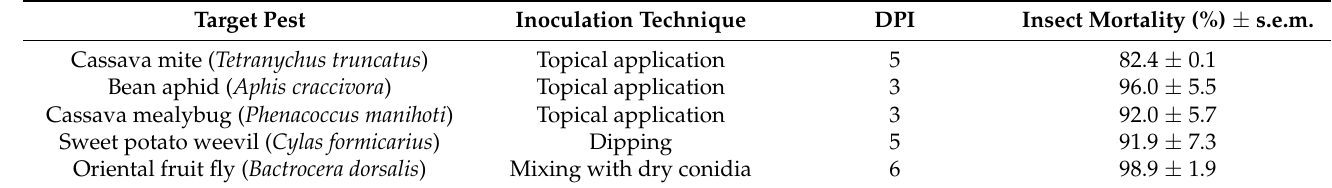
Table 2. Virulence of Metarhizium sp. BCC 4849 against various insect pests, inoculation techniques, and effects on insect mortality on days post inoculation (DPI). Conidial suspension was applied